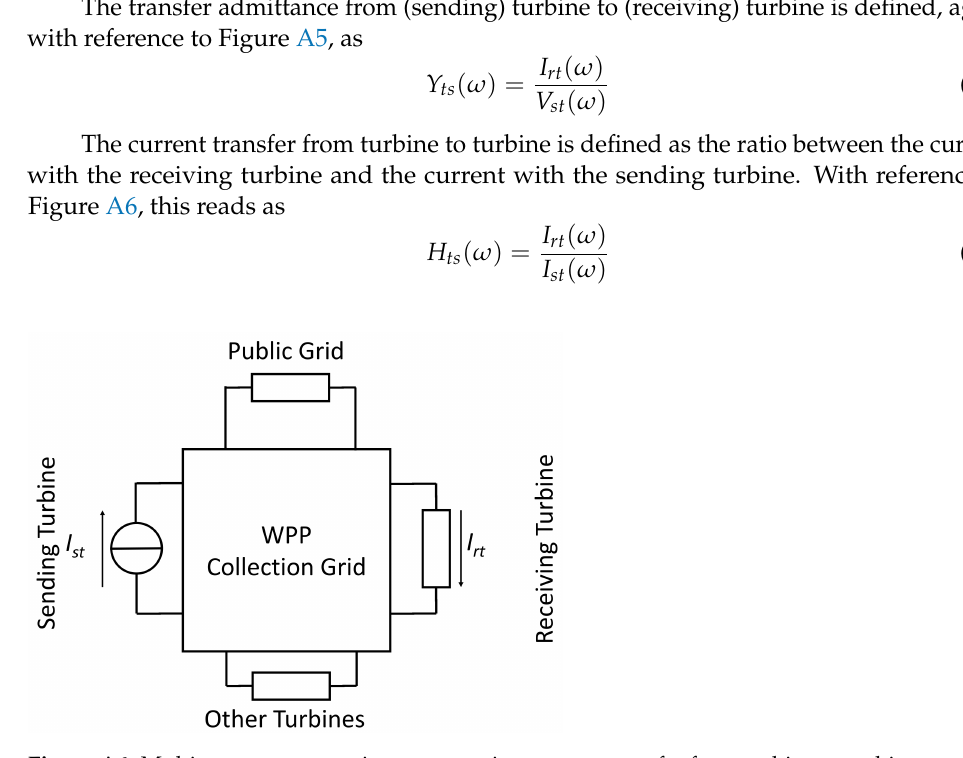
Figure A6. Multi-port representation representing current transfer from turbine to